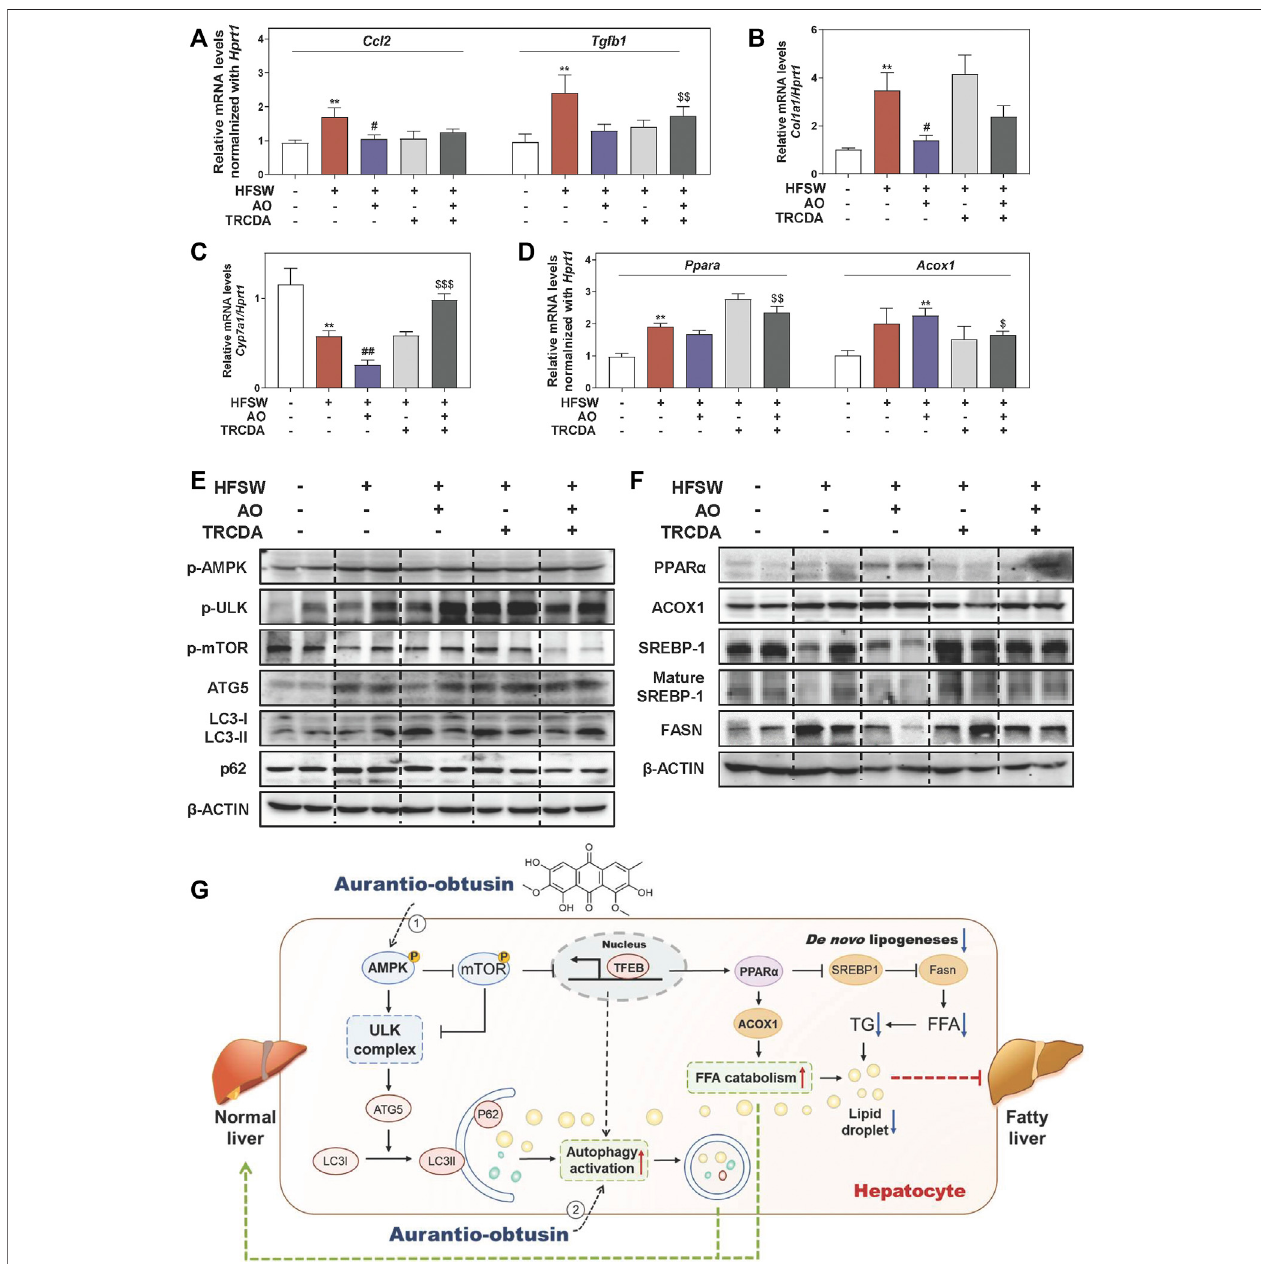
FIGURE 7 | Inhibition of ACOX1 deteriorates the AO-ameliorated liver steatosis via accelerating liver in fl ammation and fi brosis and disturbing lipid metabolism. Relative mRNA levels of (A) Ccl2 and Tgfb1 , (B) Col1a1 , (C) Cyp7a1 , (D) Ppara and Acox1 in liver tissues were determined by qPCR and normalized using Hprt1 as an internal control. The protein levels of (E) p-AMPK, p-ULK, p-mTOR, ATG5, LC3-II/LC3-I, p62, (F) PPAR α , ACOX1, SREBP-1, mature SREBP-1 and FASN in the liver were determined by western blot using β -ACTIN as a loading control, (G) Schematic diagram of the proposed mechanisms underlying the protective effects of AO on autophagy and lipid accumulation during NAFLD. Statistical signi fi cance: ** p < 0.01, compared with control group; # p < 0.05, ## p < 0.01, compared with HFSW group; $ p < 0.05, $$ p < 0.01, $$$ p < 0.001, compared with HFSW + AO group (n (cid:1) 6).